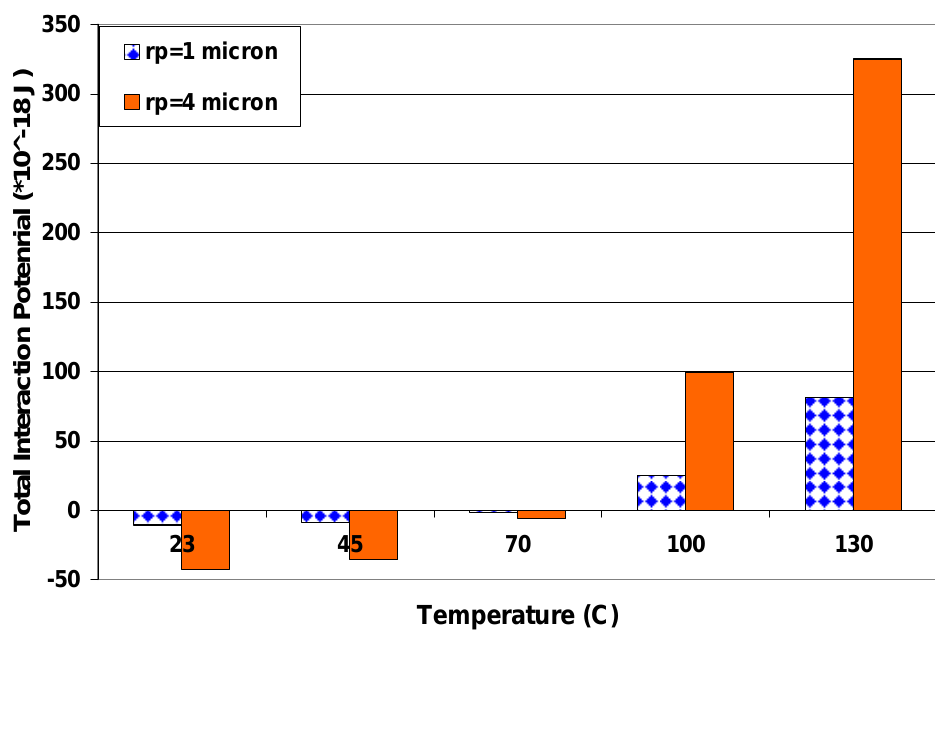
Figure 5. Estimated interaction potential for modified calcite surfaces (0.005M SA in n - decane) for water/oil/chalk (calcite) for two different particle sizes 1 and 4